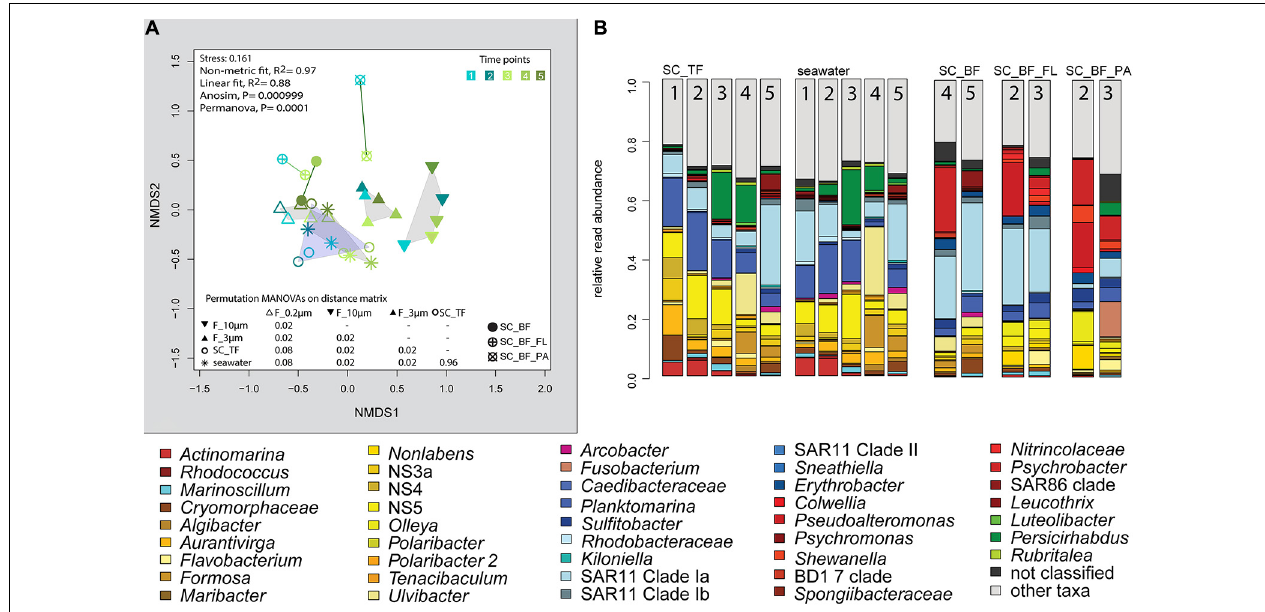
FIGURE 7 | Bacterial community diversity of unfractionated seawater and gravitationally fractionated populations obtained during a phytoplankton spring bloom off Helgoland (North Sea) in 2018. (A) Non-metric multidimensional scaling (NMDS) plot based on Bray–Curtis dissimilarity shows shifts in bacterial communities at five sampling time points (Julian Days 102, 109, 115, 128, and 142). The statistical evaluation is represented by an ANOVA, PERMANOVA, and a pairwise comparison visualized in a distance matrix (n for each group: 5). (B) Stacked bar charts of community composition. Operational taxonomic units (OTUs) shown were among the five most abundant OTUs in at least one sample. Time points are indicated as numbers inside the bars. SC_TF , sedimentation cone top fraction; SC_BF , sedimentation cone bottom fraction; SC_BF_FL , free-living population of sedimentation cone bottom fraction; SC_BF_PA , particle-attached population of sedimentation cone bottom